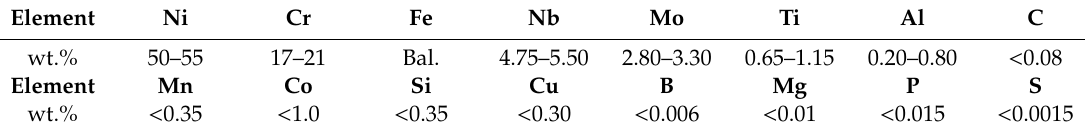
Figure 1. Schematic depicting the geometry and dimensions of the test specimens. Specimen building direction (BD), grain orientation, and welding direction (WD) are also illustrated in the image. Table 1. Nominal chemical composition of the gas atomized Alloy 718 powder (wt.%).